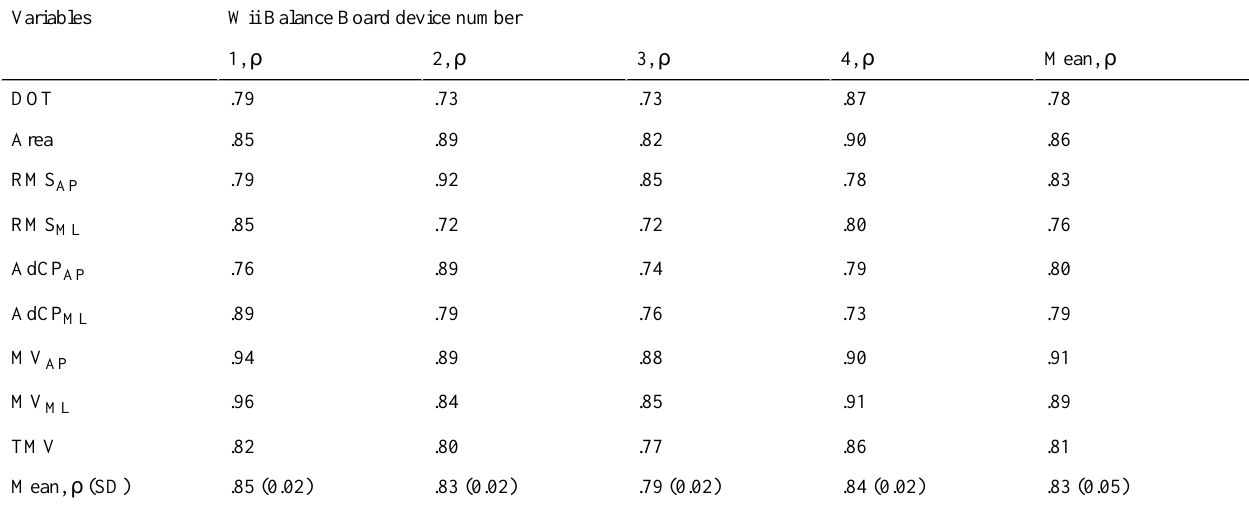
Table 3. Spearman correlation coefficients between the force plate and the 4 different Wii Balance Board devices. Wii Balance Board device